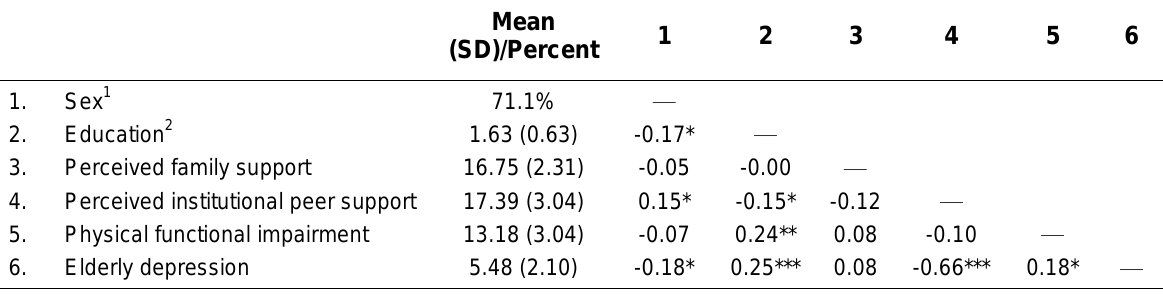
Descriptive and Correlation Analyses of Major